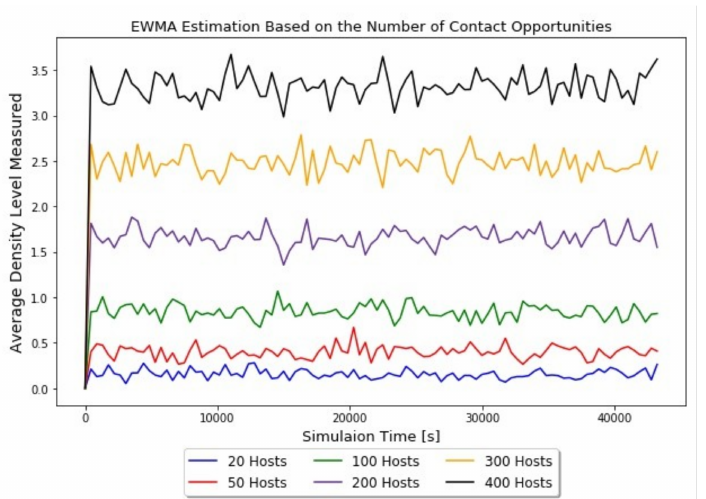
Figure 1. Evolution of the average density level measured considering distinct density